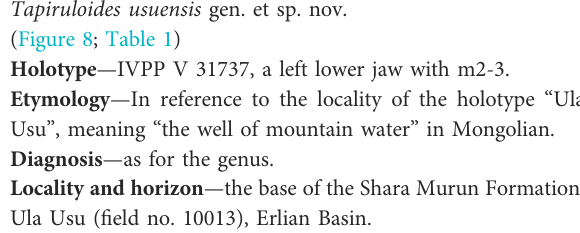
Material — IVPP V 31735, a left m1/2 from the Irdin Manha Formation at Huheboerhe ( fi eld no. 13088).